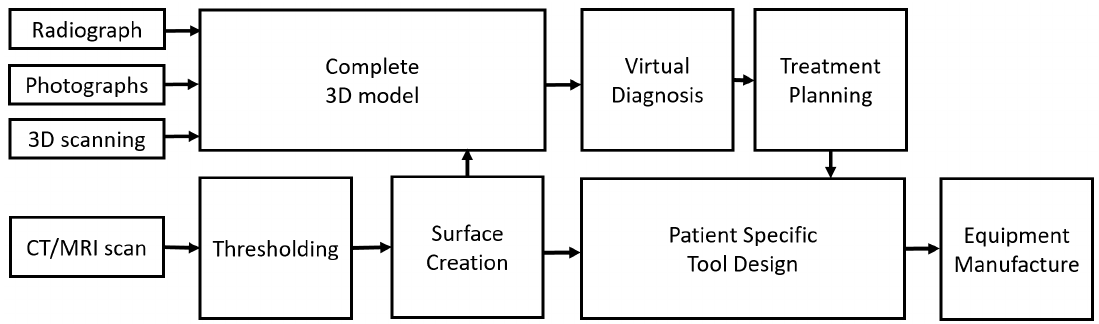
Figure 3. Detailed VSP procedure.